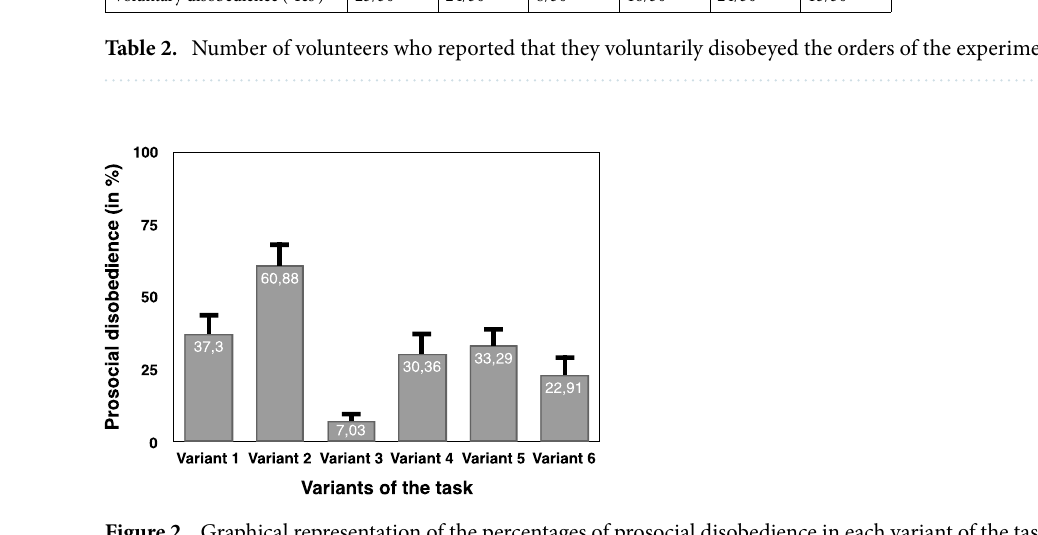
Figure 2. Graphical representation of the percentages of prosocial disobedience in each variant of the